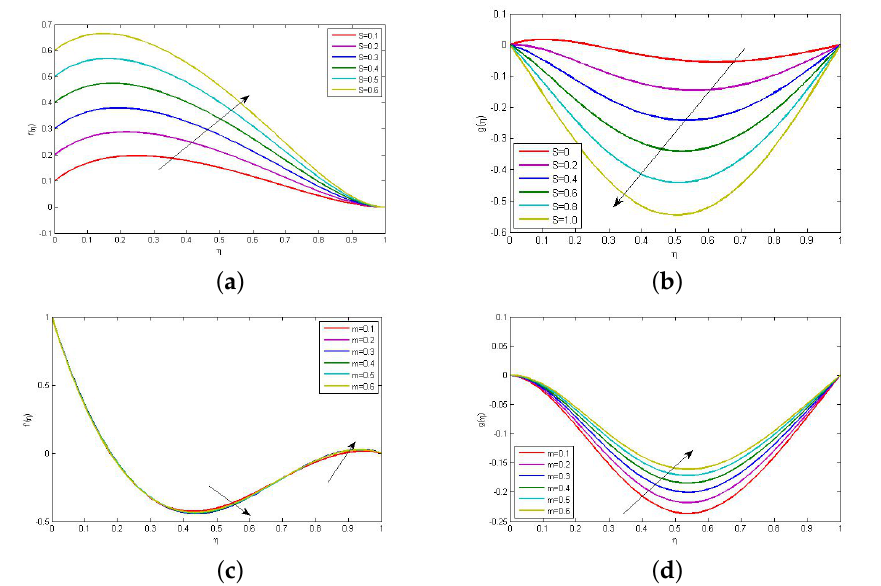
Figure 5. Dependence of ( a ) S on f (cid:48) ( η ) ( c ) m on f (cid:48) ( η ) ( b ) S on g ( η ) ( d ) m on g ( η ) ,